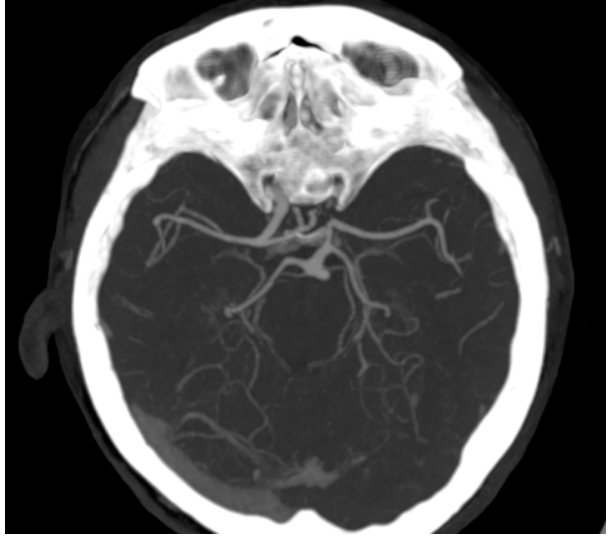
Figure 3. Cerebral CT angiography with MIP axial reconstruction: anatomic variation in the circle of Willis showing the absence of the A1 segment of the left ACA and right PCOM and compensatory well-represented left PCOM.